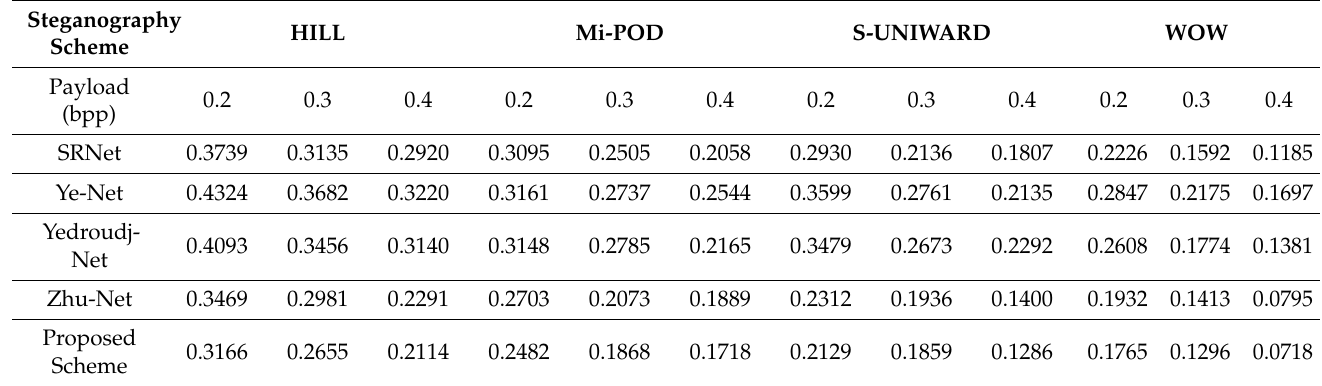
Table 8. Detection errors of proposed and other schemes using augmented